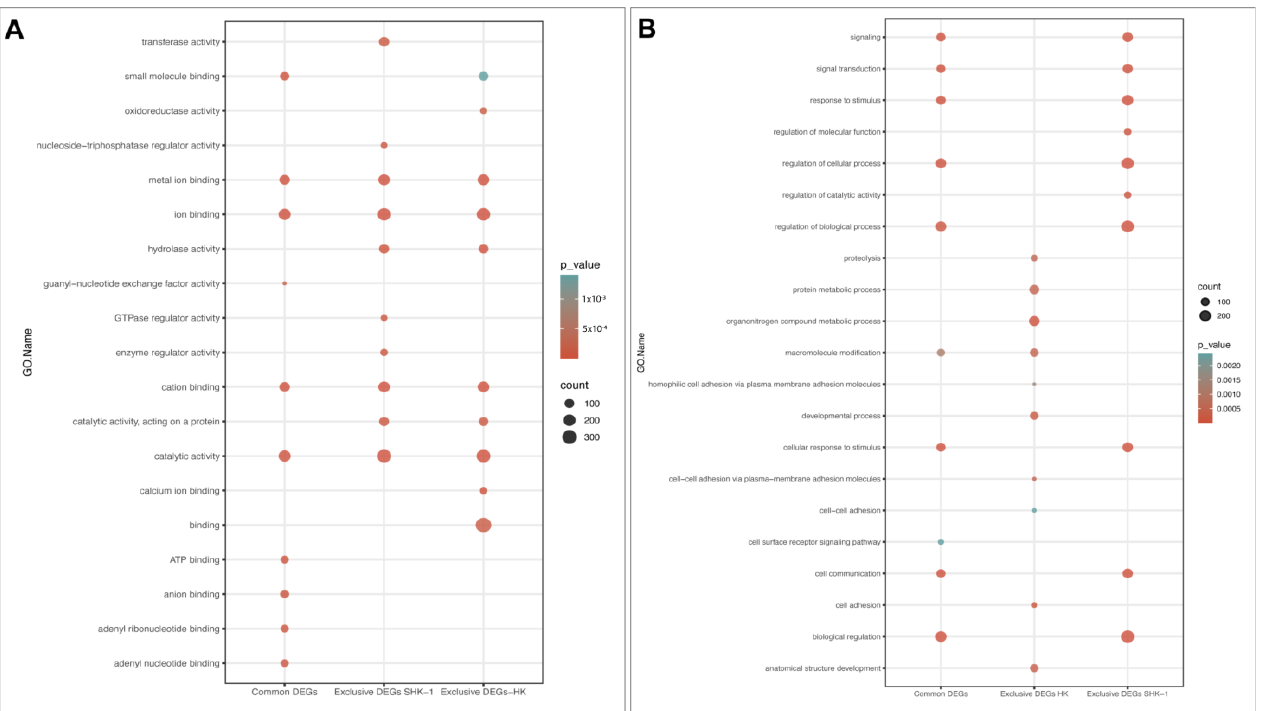
Figure 2. GO enrichment analysis for exclusive and common DEGs of the SHK-1 cell line and salmon HK exposed to recombinant Cr-cathepsin. ( A ) Top-20 of molecular function. ( B ) Top-20 of biological process.